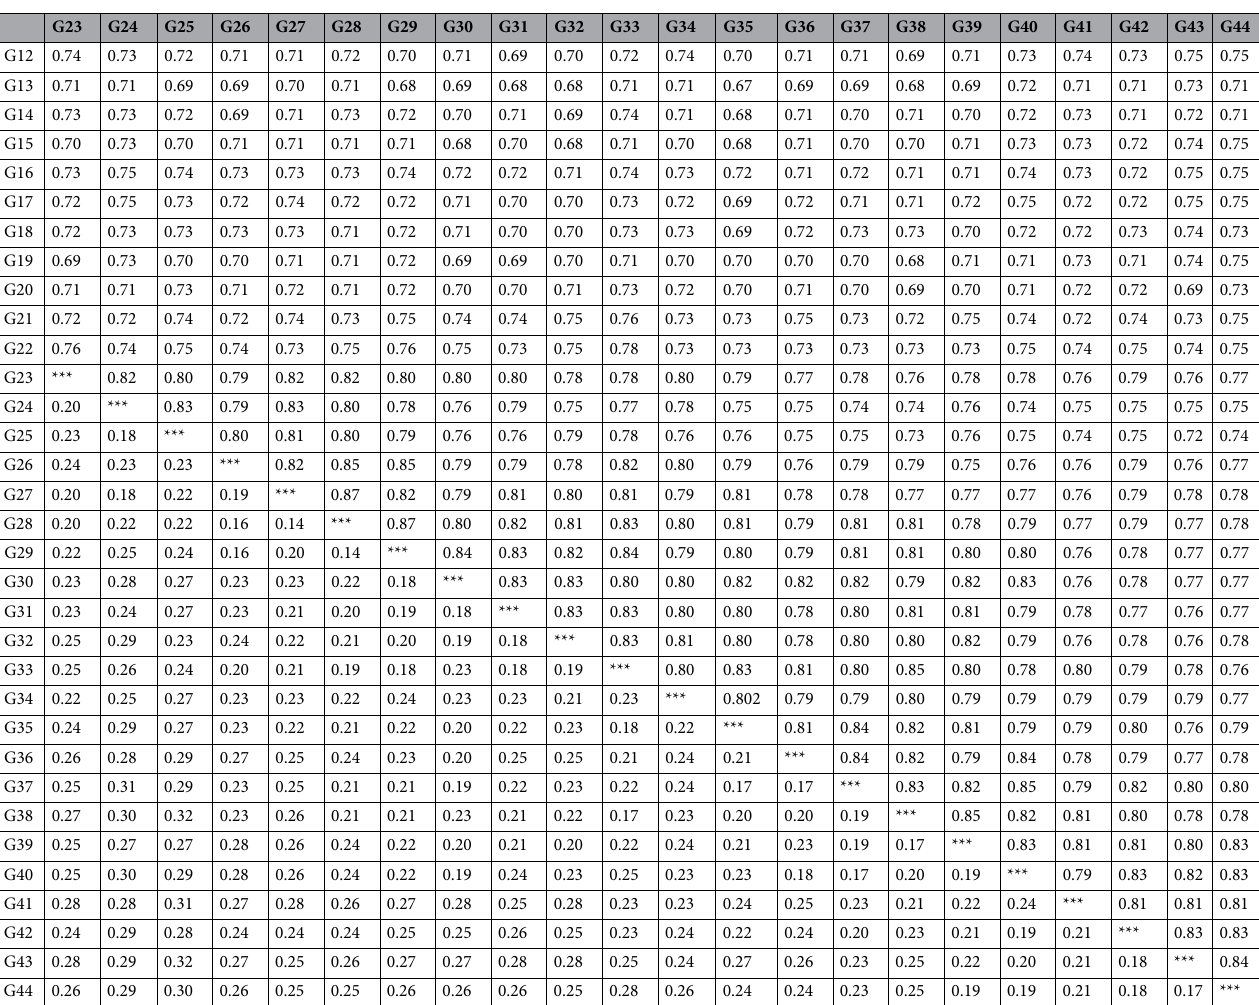
Table 4. Distance matrix (below diagonal) and identity (above diagonal) based on Nei’s original measures for the 44 V . subterranea genotypes revealed by ISSR